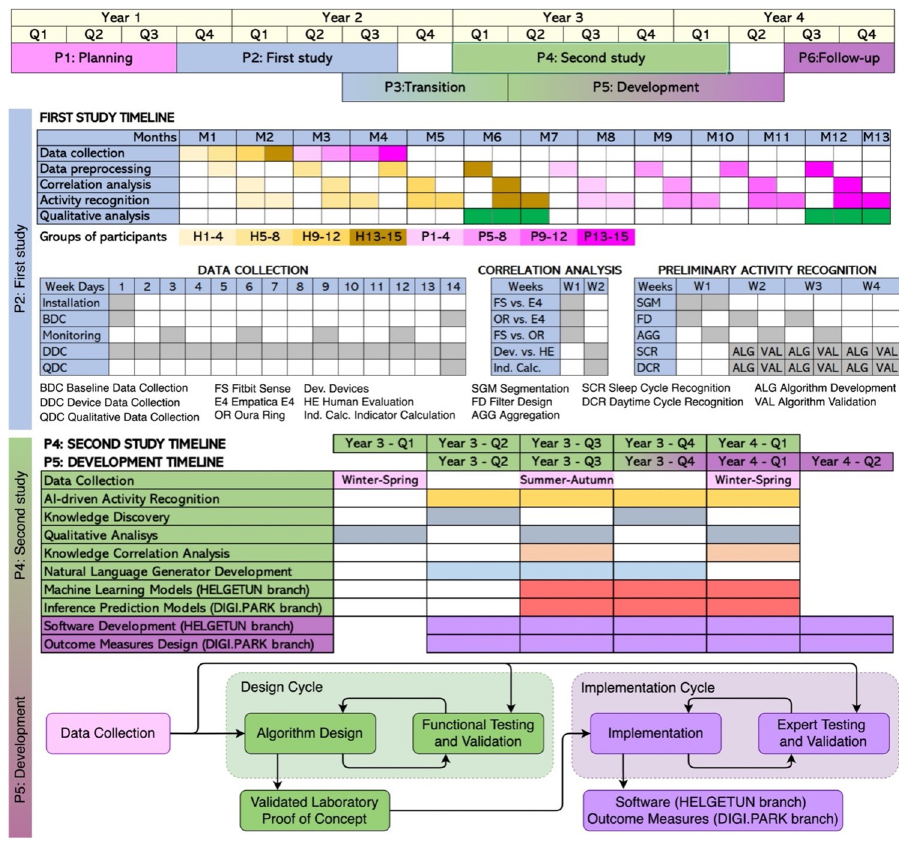
Fig 4. ActiveAgeing timeline and development